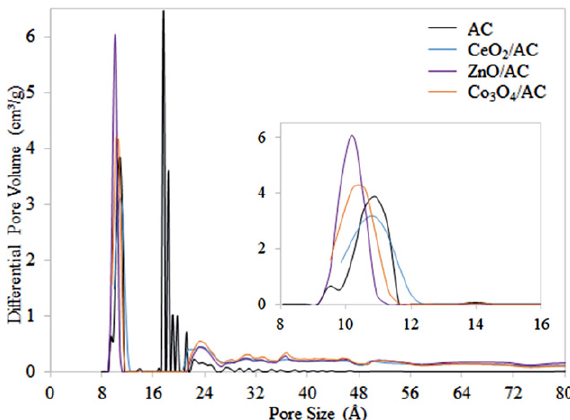
Figure 3. Pore size distribution with the inset image shows clearer pore size distribution at the range of 8-12 Å (0.8–1.2